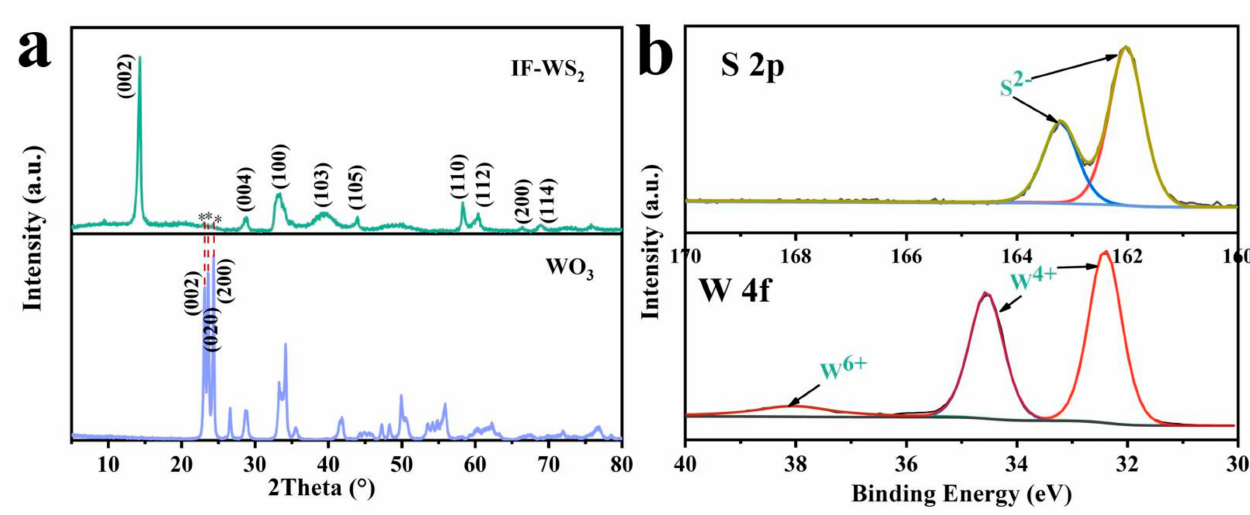
Figure 3. ( a ) The X-ray Diffraction (XRD) patterns of IF–WS 2 NPs; ( b ) X-ray photoelectron spectroscopy (XPS) spectra of S 2p, W